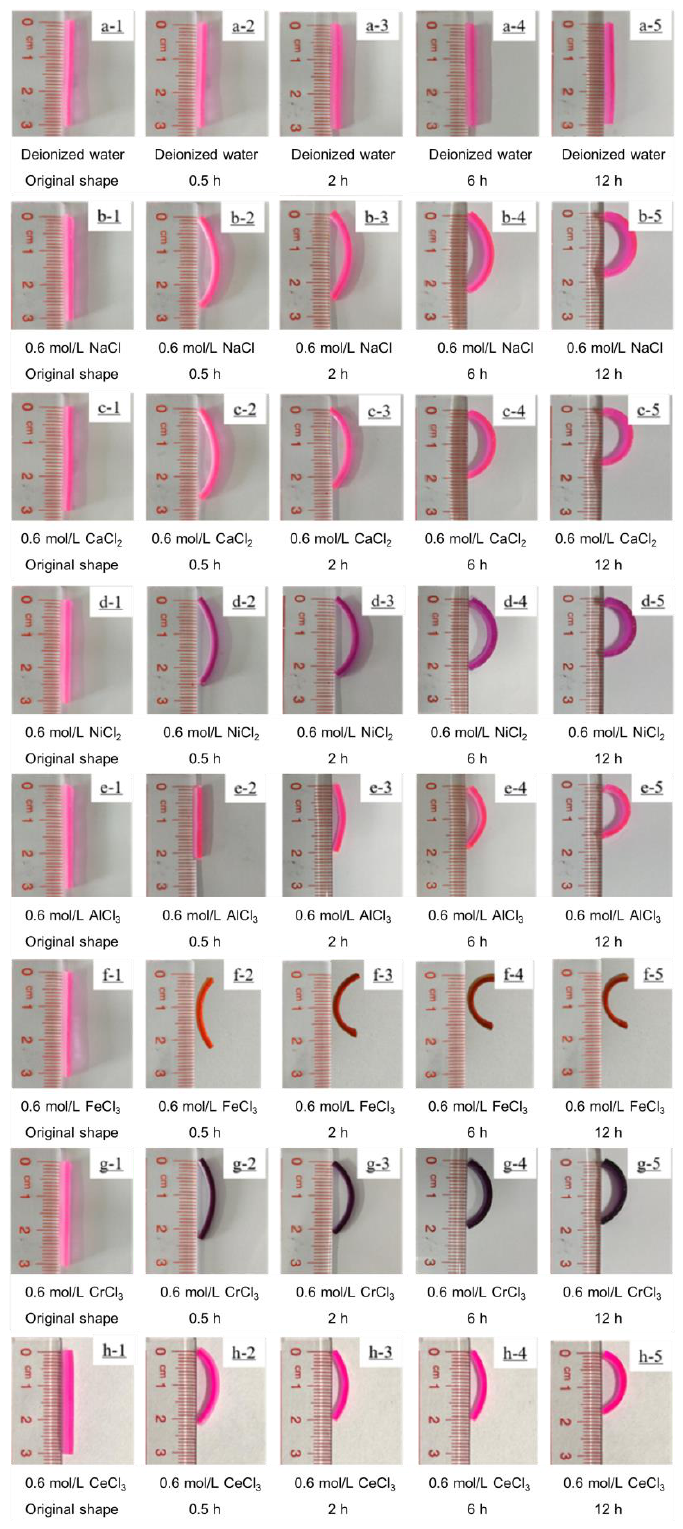
Figure 4. Self-deformation behavior of bilayer hydrogel actuators in 0.6 mol/L NaCl solution ( b1 – b5 ), 0.6 mol/L CaCl 2 solution ( c1 – c5 ), 0.6 mol/L NiCl 2 solution ( d1 – d5 ), 0.6 mol/L AlCl 3 solution ( e1 – e5 ), 0.6 mol/L FeCl 3 solution ( f1 – f5 ), 0.6 mol/L CrCl 3 solution ( g1 – g5 ), and 0.6 mol/L CeCl 3 ( h1 – h5 ). Hydrogel actuators were placed in deionized water ( a1 – a5 ) as a control. In all images, the NIPAM hydrogel layer is on the left and the AAm/AAc hydrogel layer is on the